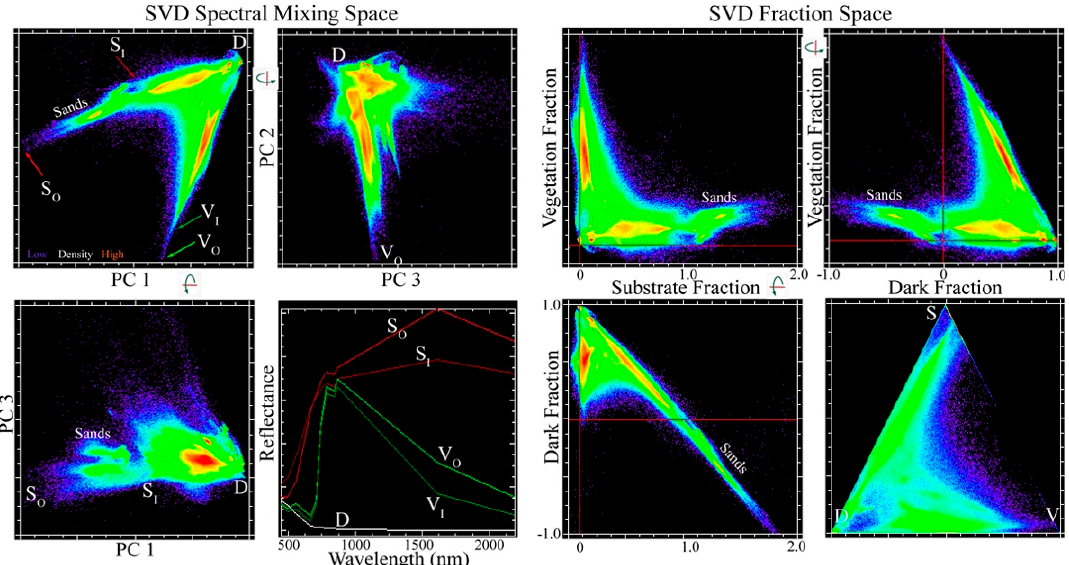
Figure 5. Sentinel 2 SVD spectral mixing space, spectral endmembers, and the corresponding SVD fraction space. An eight column (80,000,000 spectra) subset of the Land Cover Subcategory mosaic encompassing the SVD-bounded plane of the full mixing space is effectively 2D with PC dimensions 1 (81%) and 2 (14%) accounting for 95% of total variance, compared to PC 3 (2%). Maximum amplitude (Outer) and lower amplitude mean (Inner) endmember spectra for Substrate and Vegetation define bases for maximal and minimal SVD models (left). Inversion of the minimal model provides liberal estimates of SVD fractions (right), but excludes pure sand landscapes. Because sands lie outside the minimal SVD model, their Substrate fractions exceed 1.0 with Dark fractions < 0. The resulting planar SVD fraction distribution can be projected onto a 2D ternary diagram (lower right) with no loss of information.